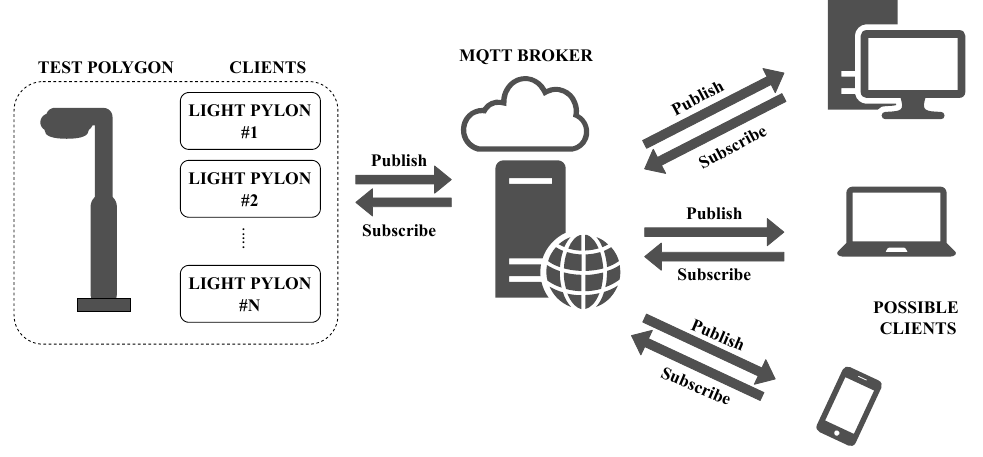
Figure 11. Diagram of possible MQTT